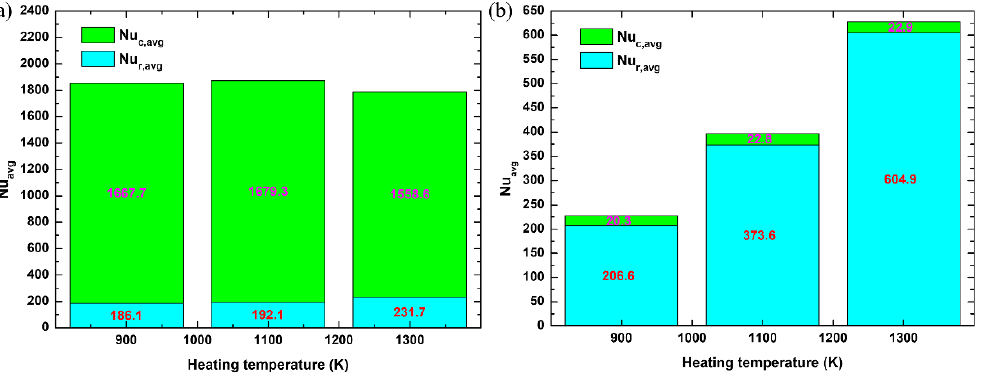
Figure 12. Variation in the average Nusselt numbers with the wall temperature for ( a ) wall_1; ( b ) wall_2.